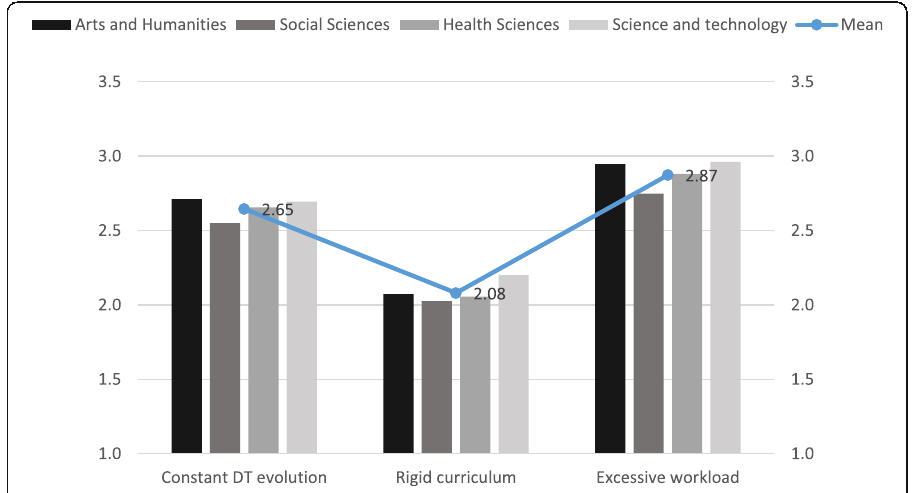
Fig. 5 Mean ranking for contextual barriers to DT integration according to academic